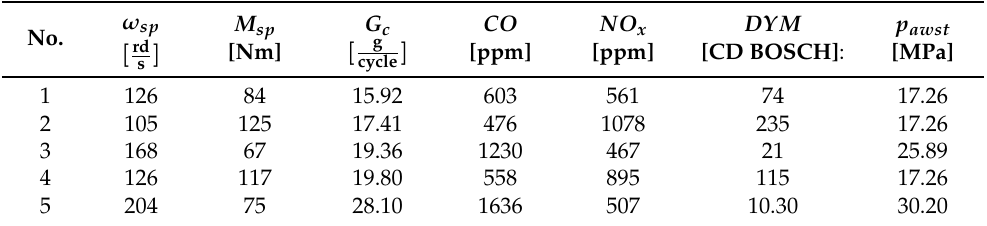
Table 7. Parameters of combustion engine duty points determined for accumulator with capacity V a = 0.03 [m 3 ] (load